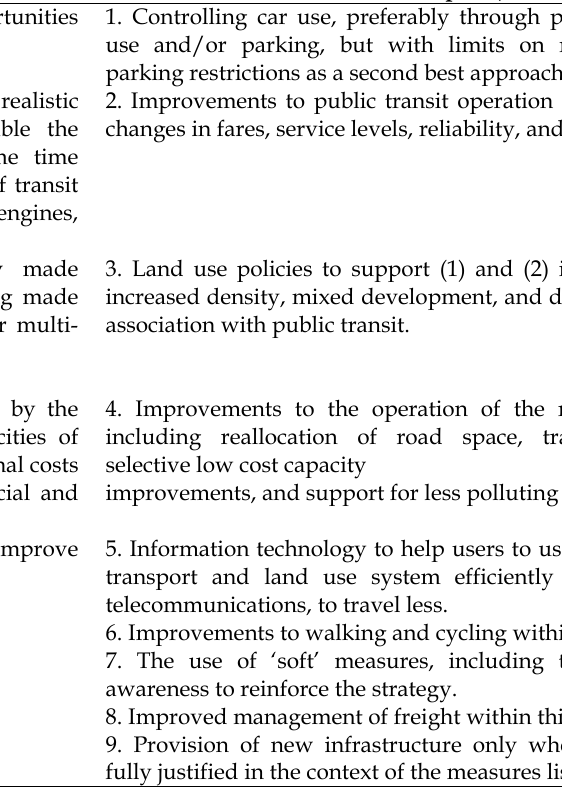
Table 1. Priorities in The Implementation of A Sustainable Urban Transport Strategy Bertolini and le Clerq (2003: